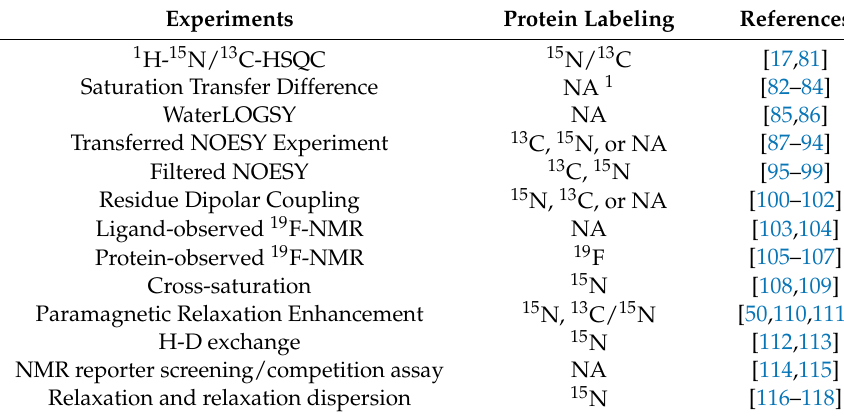
Table 1. List of commonly used NMR experiments for probing protein-ligand interactions. Experiments